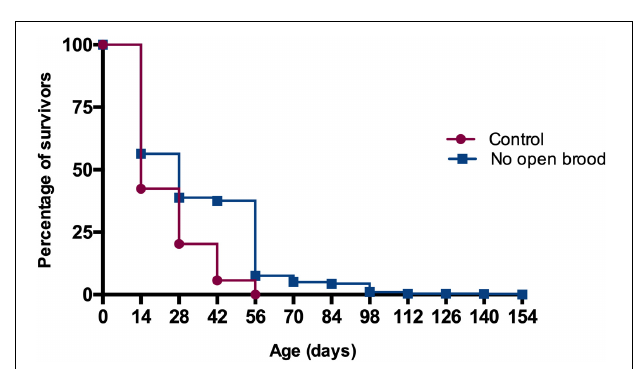
FIGURE 4 | Worker longevity is significantly higher in colonies with no open brood in comparison with control colonies (Kaplan-Meier Survival Analysis Log-Rank p << 0.05).